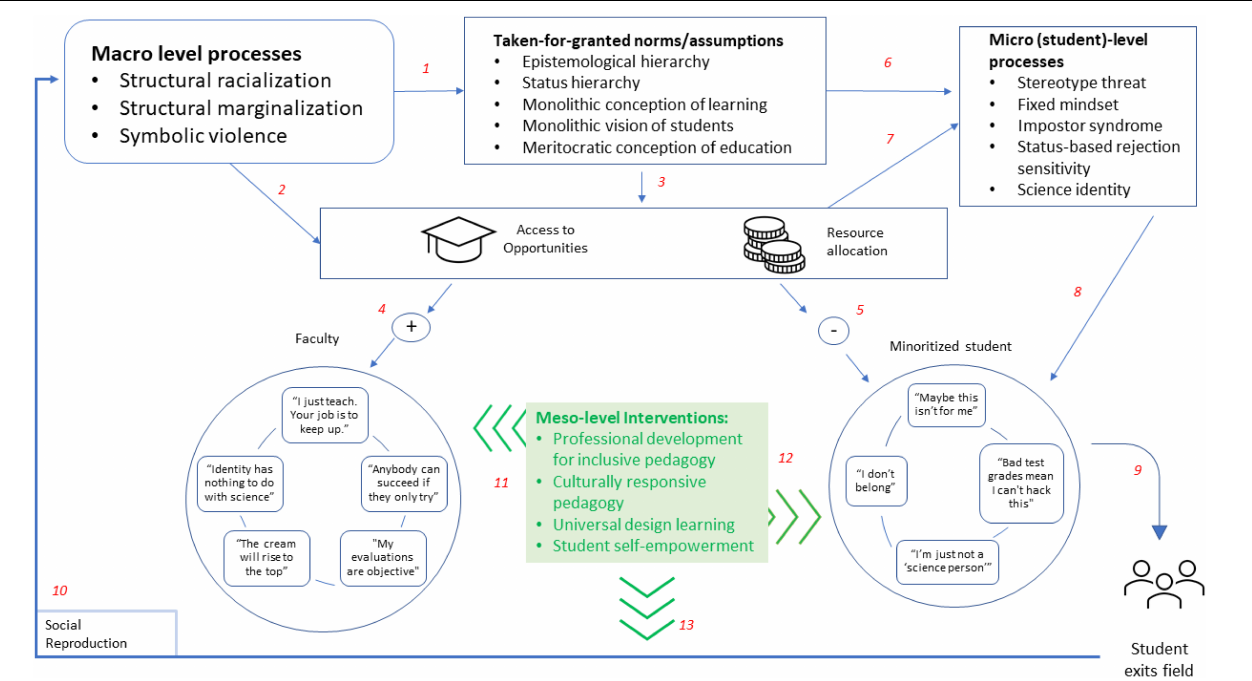
FIGURE 1 | Relationships between micro, meso, and macro level